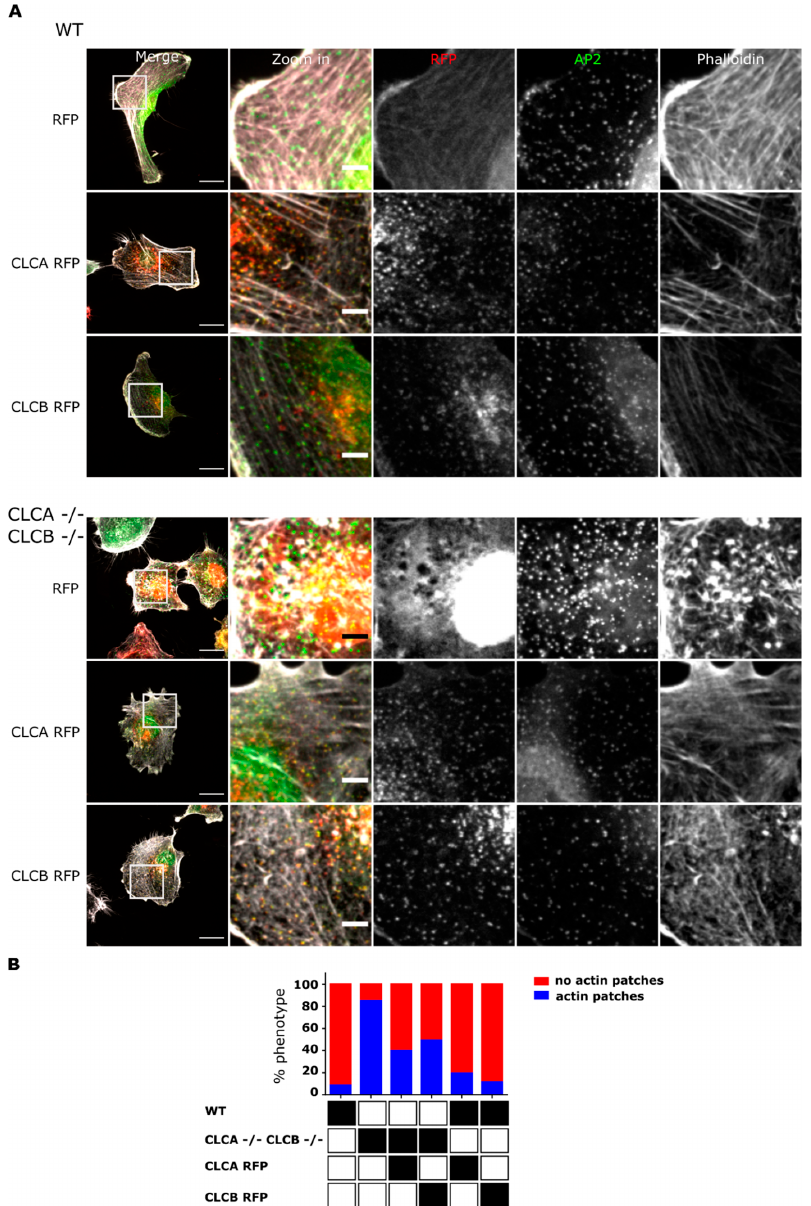
Figure 2. Trans-complementation of CLCs in CLCA − / − CLCB − / − cells rescues actin patch formation. ( A ) U373 WT and CLCA − / − CLCB − / − cells stably expressing the clathrin adaptor AP2 fused to GFP (green) were transfected with either RFP tag alone, CLCA RFP or CLCB RFP (red). Cells were fixed and stained with Alexa fluor 647-labelled phalloidin for actin visualization (grey). Representative confocal images are shown, scale bar indicates 20 µ m for merge and 5 µ m zoom in. ( B ) Relative percentage of actin phenotype among cell population. Cells displaying actin patches vs. cells without actin patches were quantified. Only RFP-positives were counted and used for analysis. 10 fields of view were analyzed. WT and RFP 161 cells, WT and CLCA RFP 133 cells, WT and CLCB RFP 92 cells, CLCA − / − CLCB − / − and RFP cells 175 cells, CLCA − / − CLCB − / − and CLCA RFP 184 cells, CLCA − / − CLCB − / − and CLCB RFP 210